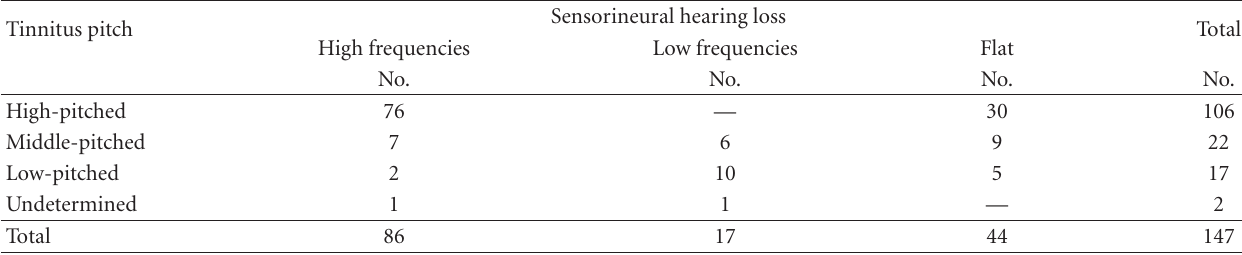
Table 4: Tinnitus subjects and SNHL: distribution according to type of SNHL and tinnitus pitch. Tinnitus pitch